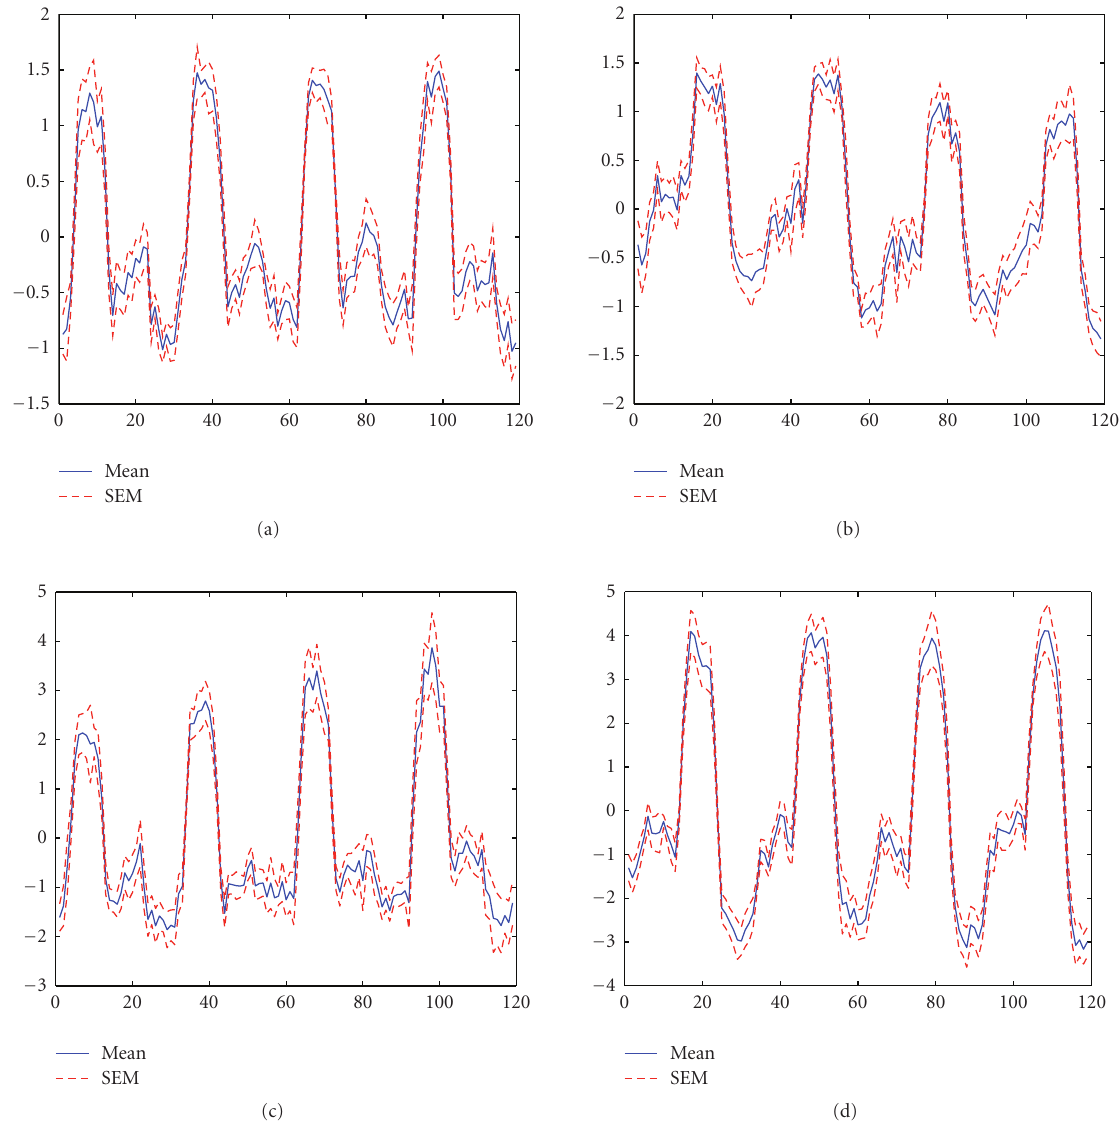
Figure 4: Averaged time courses of the two task-related components with the standard error of the mean (SEM). (a) Right visuomotor time course of Infomax, (b) left visuomotor time course of Infomax, (c) right visuomotor time course of FS-Infomax, (d) left visuomotor time course of